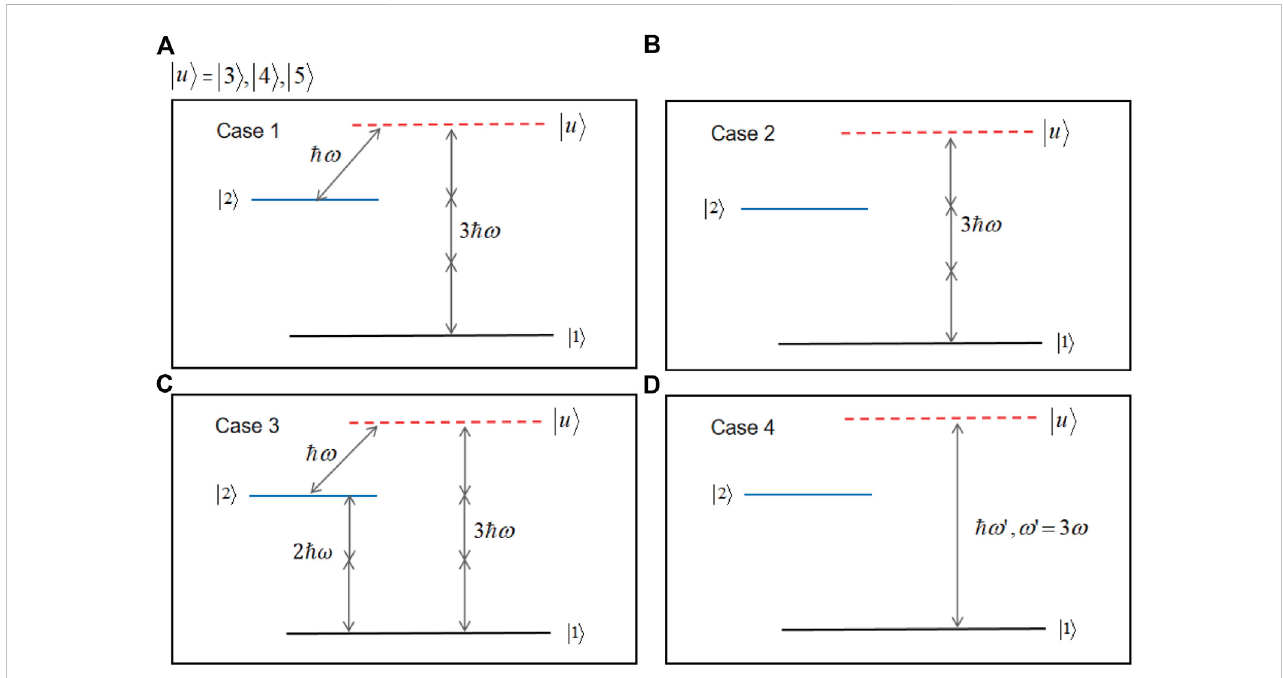
FIGURE 3 The four cases with the consideration of different coupling conditions. (A) Case 1: The one-photon coupling between |2 〉 and | u 〉 and the three-photon couplingbetween|1 〉 and| u 〉 areconsidered. (B) Case2:Onlythethree-photoncouplingbetween|1 〉 and| u 〉 isconsidered. (C) Case3:Alltheone-,two-and three-photon couplings are taken into account. In Cases 1 – 3, the laser wavelength is 840 nm. (D) Case 4: The one-photon coupling between |1 〉 and | u 〉 is considered with the wavelength setting to be 280